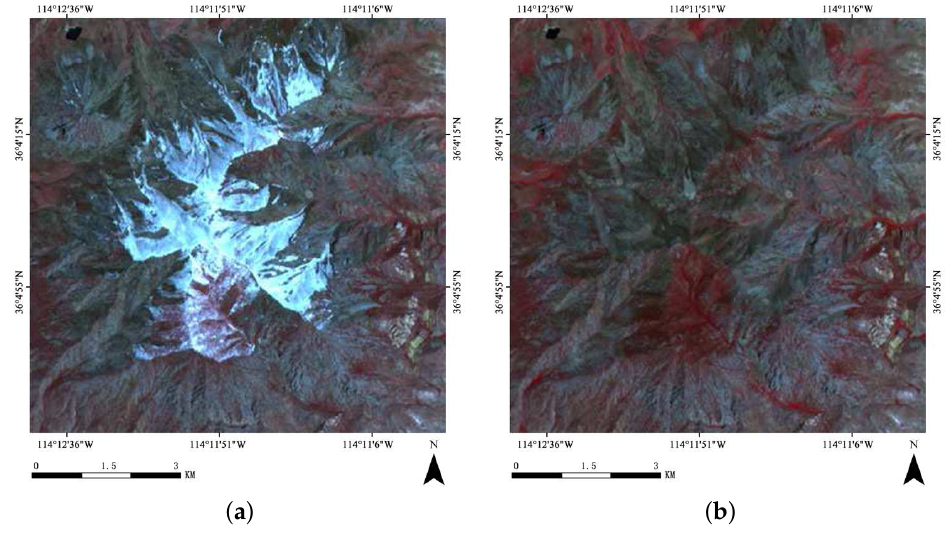
Figure 6. ASTER data set. The size of ASTER images is 400 × 400 pixels with 15 m spatial resolution. ( a ) Mountain Hillers, ASTER, 6 May 2005; ( b ) Mountain Hillers, ASTER, 19 July 2005.